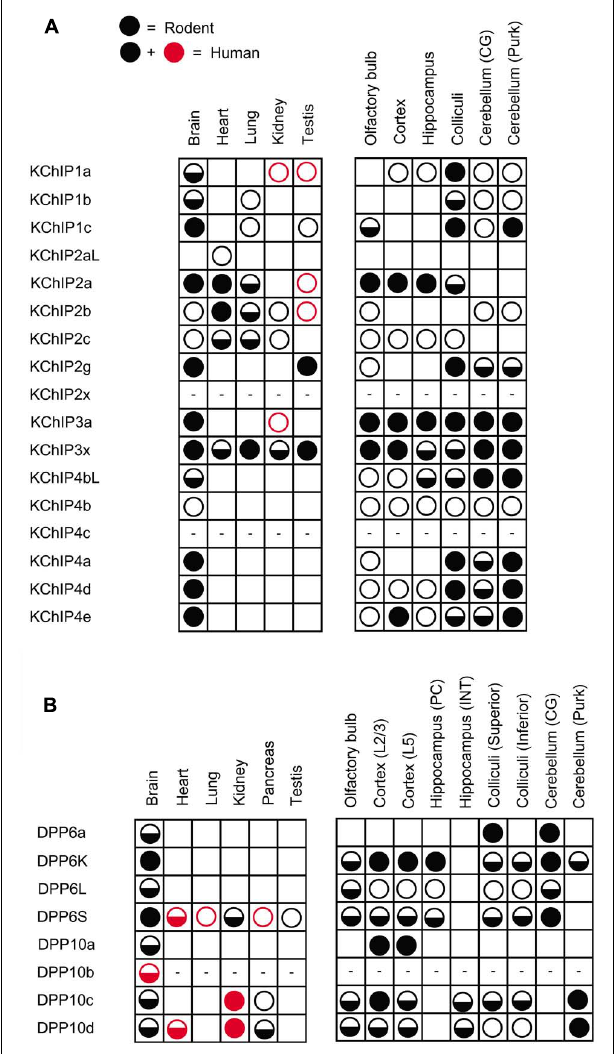
FIGURE 3 | Differential expression of auxiliary subunit N-terminal variants in various tissues and brain regions in mouse and human. (A) Summary of the expression patterns of KChIP N-terminal variants in mouse (black) and human (black and red): KChIP1 (Van Hoorick etal., 2003; Pruunsild andTimmusk, 2005), KChIP2 (Takimoto etal., 2002; Pruunsild and Timmusk, 2005), KChIP3 (Pruunsild andTimmusk, 2005), and KChIP4 (Holmqvist etal., 2002; Pruunsild andTimmusk, 2005). (B) Summary of the expression patterns of DPLP N-terminal variants in mouse (black) and human (black and red): DPP6 (Wada etal., 1992; de Lecea etal., 1994; Kin etal., 2001; Radicke etal., 2005; Nadal etal., 2006; Maffie etal., 2009; Jerng and Pfaffinger, 2012) and DPP10 (Chen etal., 2006a;Takimoto etal., 2006; Jerng etal., 2007). No symbols, no expression; open circle, low expression; half-filled circle, moderate expression; filled circle, high expression; dash, not determined; CG, cerebellar granule cells; Purk, cerebellar Purkinje cells; PC, pyramidal neuron; INT, interneuron; L2/3, layer 2 and 3; L5, layer 5.